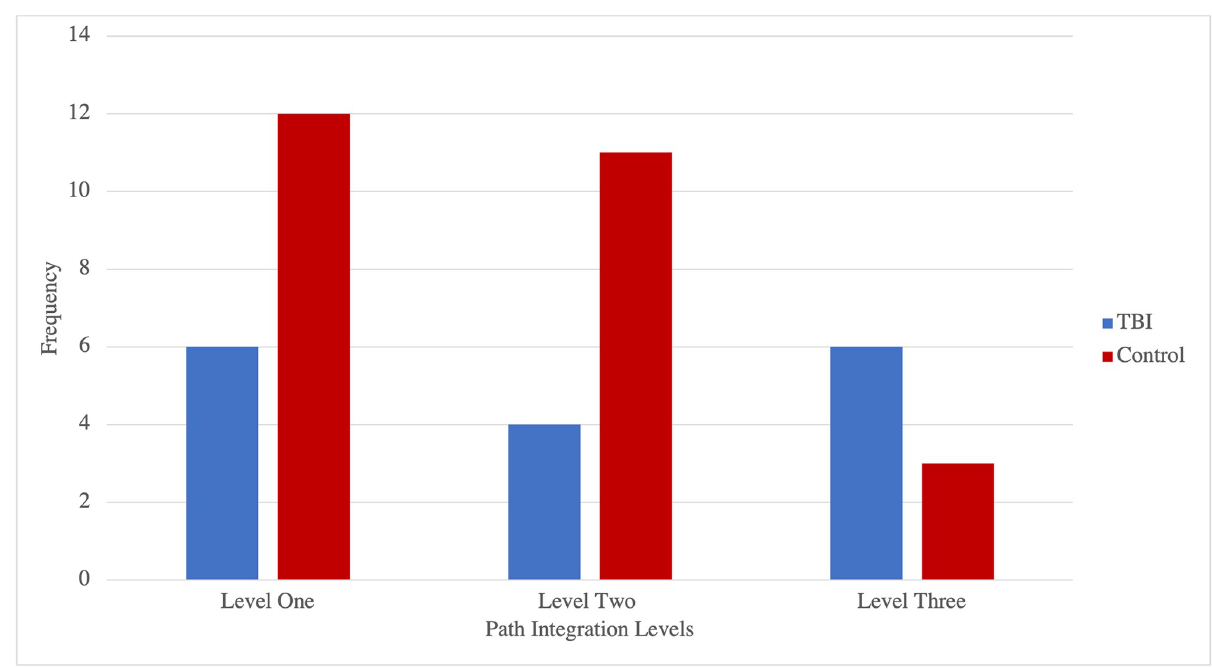
Fig 7. Frequencies of TBI and control participants as a function of flare accuracy (i.e., selection of correct starting location) on path integration levels.